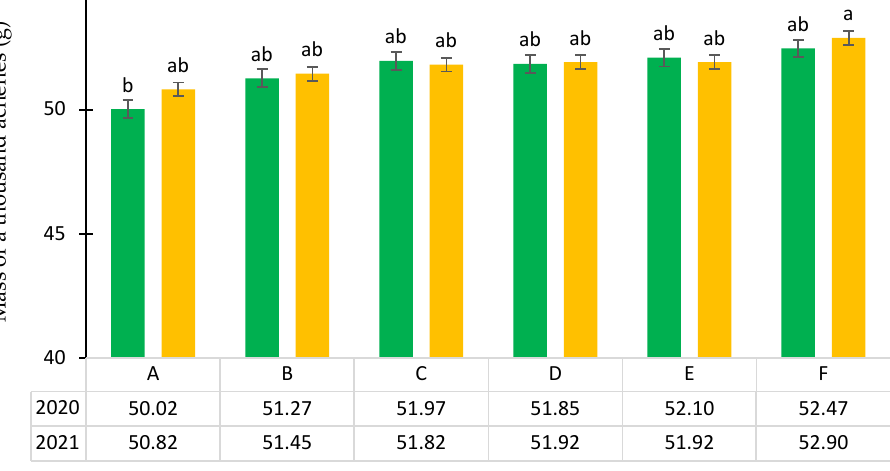
Figure 4. Mass of a thousand achenes (g). A–F—variants of fertilization. Different lowercase letters indicate significant differences ( p < 0.05) according to the analysis of variance (ANOVA).